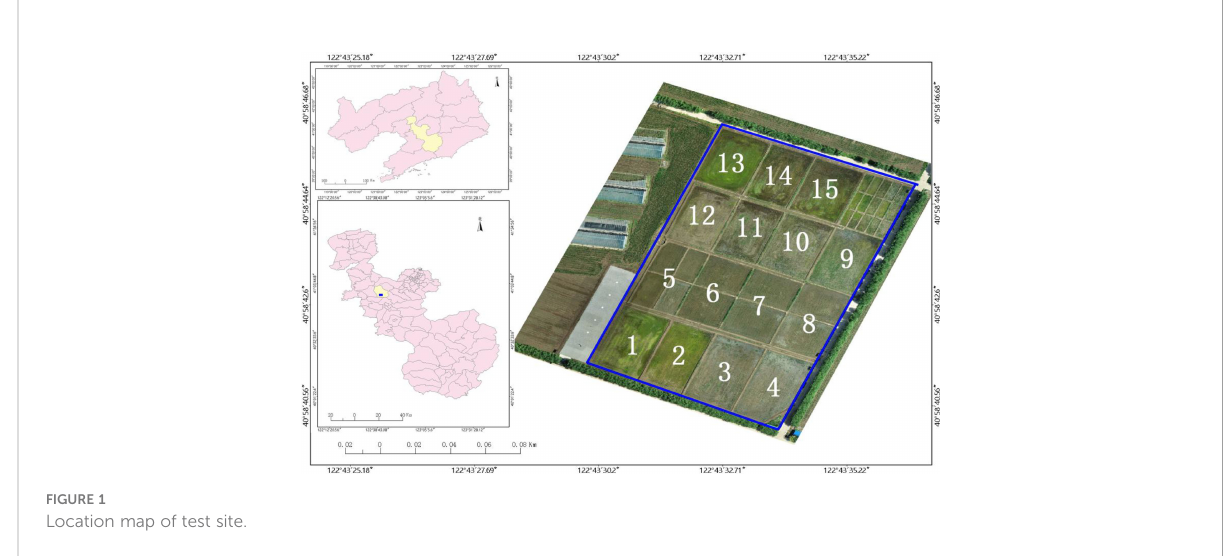
FIGURE 1 Location map of test